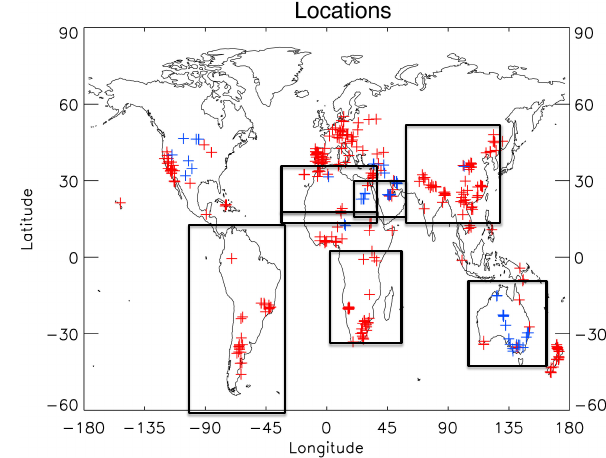
Fig. 1. Location of the data collected for this work (in red) and from Claquin et al. (1999) (in blue). The rectangles delimit regions studied in Fig.